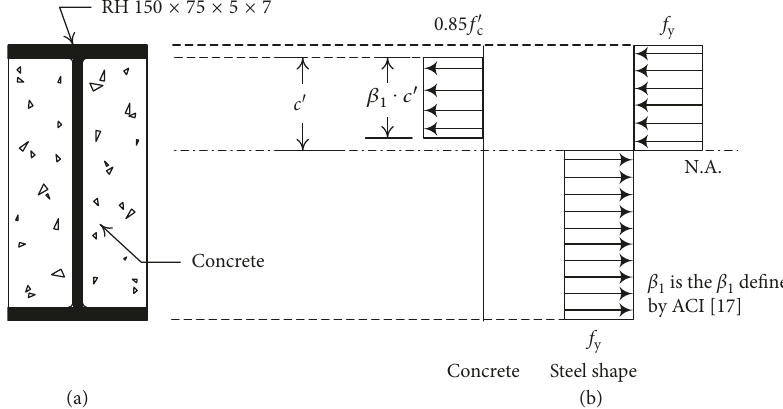
Figure 4: (a) Cross section. (b) Plastic stress distribution method, AISC [16].